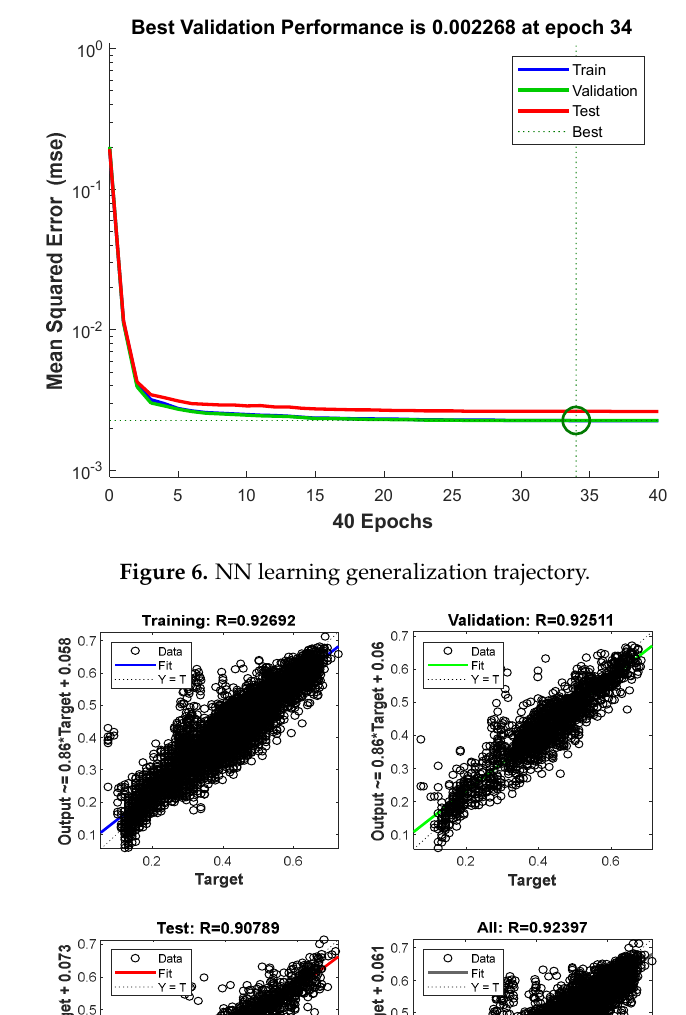
Figure 7. Regression effect of training/test/validation (set) regression effect. Appl. Sci. 2019 , 372 , 372 Figure 7 . Regression effect of training/test/validation (set) regression effect.